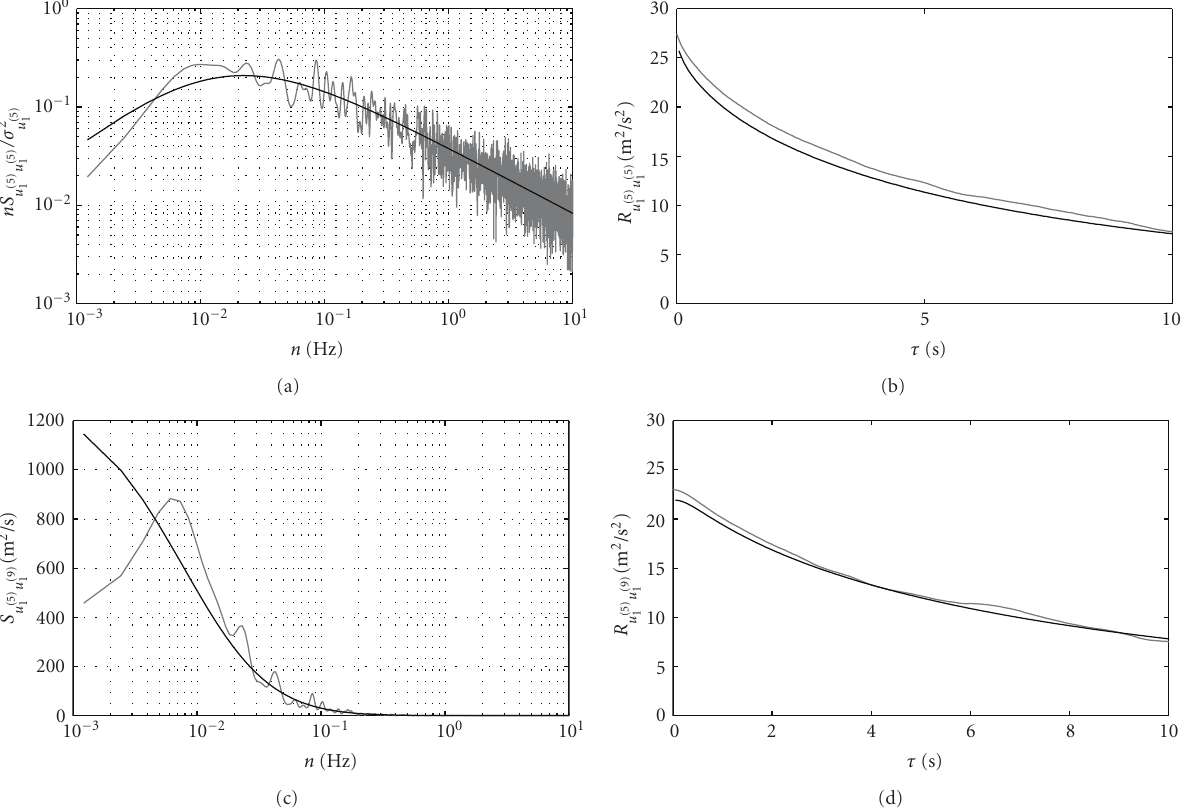
Figure 7: Example 1 using POD method (black lines denote target functions, gray lines denote numeric approximations): autospectrum of along-wind velocity at point 5 (a); corresponding autocorrelation function (b); cross-spectrum between along-wind velocities at points 5 and 9 (c); corresponding cross-correlation function